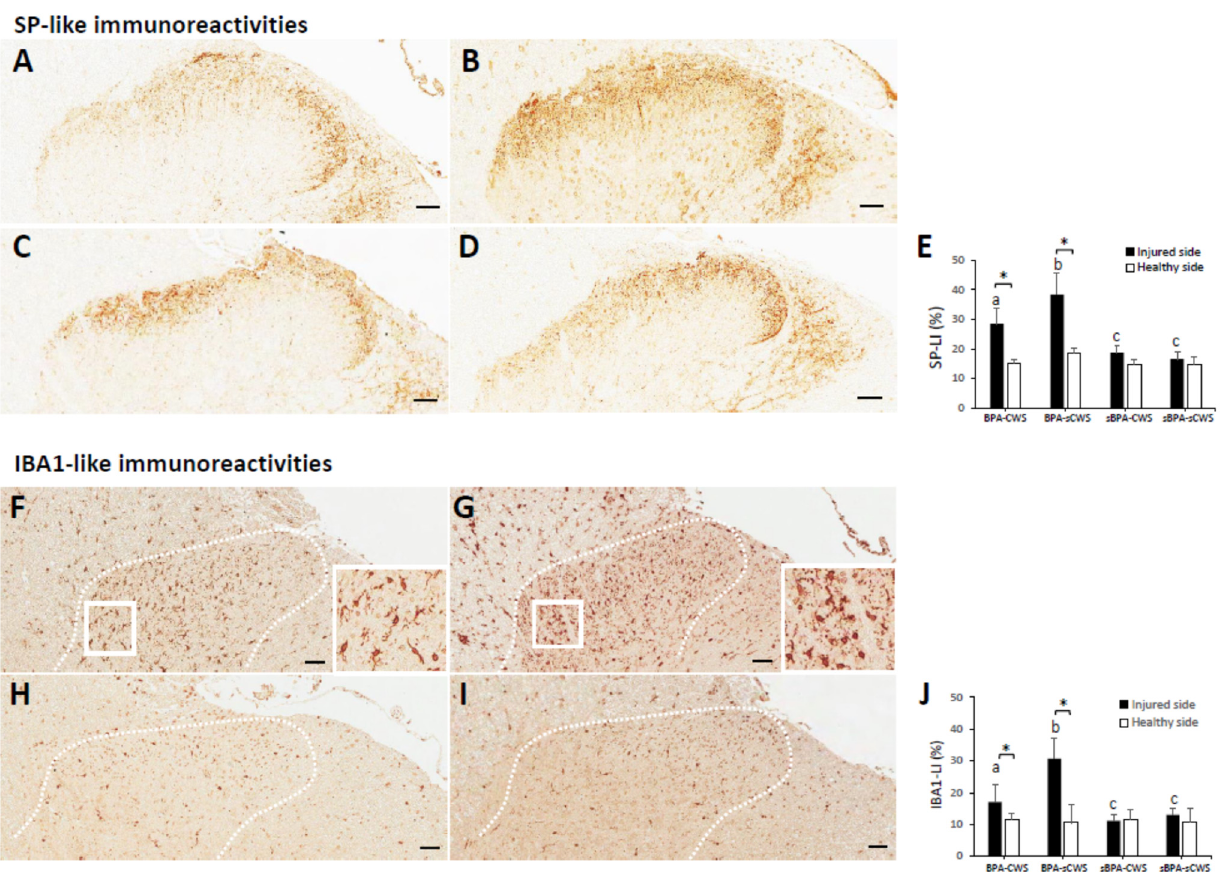
Figure 3. Representative SP-like and IBA1-like immunoreactivities (SP-LI and IBA1-LI) in sections of dorsal horns of C5-T1 in rats of BPA–CWS ( A , F ), BPA–sCWS ( B , G ), sBPA–CWS ( C , H ) and sBPA– sCWS ( D , I ) groups. The distributions of SP-LI staining area were mostly located in Laminae I and II while IBA1 expression was located in dorsal horns. Data of SP-LI ( E ) and IBA1 ( J ) in dorsal horns are presented as mean ± SD. Values with different superscripts (e.g., a vs. b and b vs. c) indicate significant differences ( p < 0.05) for all possible pairwise comparisons of means analyzed using Mann–Whitney tests. * indicates significant difference (p < 0.05) between injured and healthy sides analyzed using paired t-tests. Scale bars, 50 μ m.